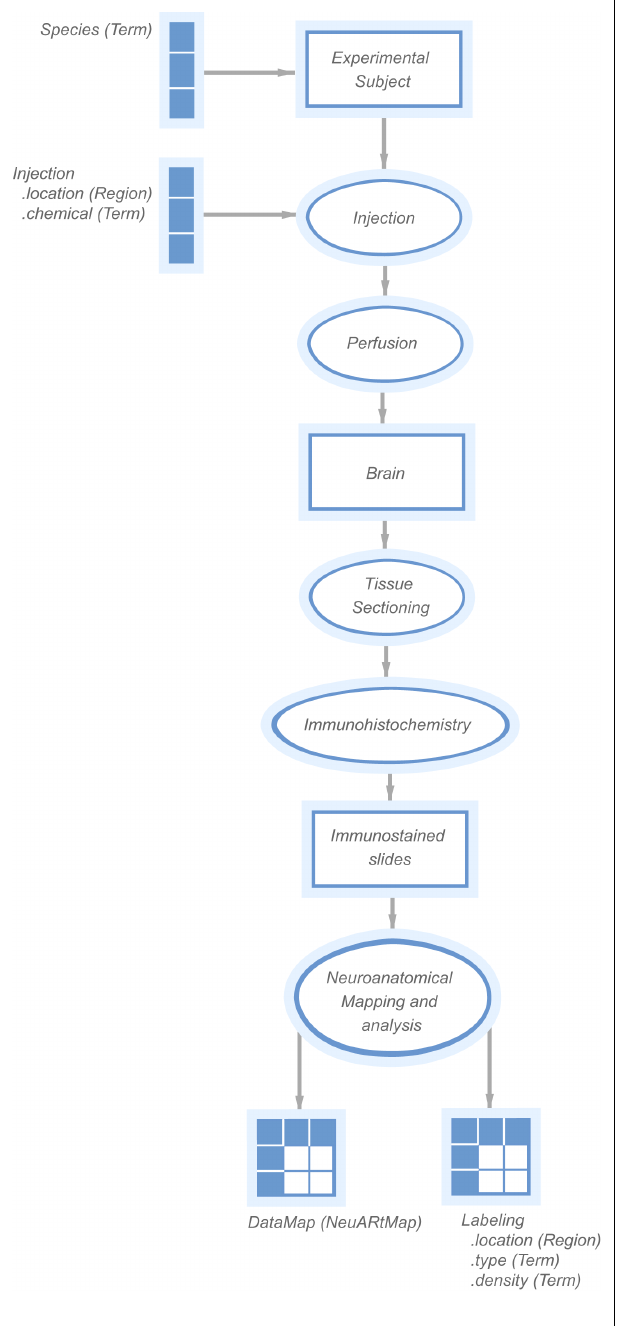
the bottom right. Each map denotes a single experimental case mapped over several atlas plates. Two basic components display these maps (a) views of an individual level with all data maps superimposed and (b) a view of all available levels within a single experimental case. These components appear as tabbed panes in the central panel which may itself be divided either vertically